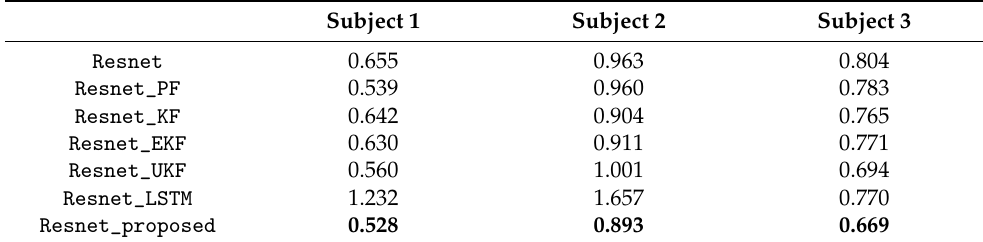
Table 1. The RMSE of the results obtained by the seven methods.